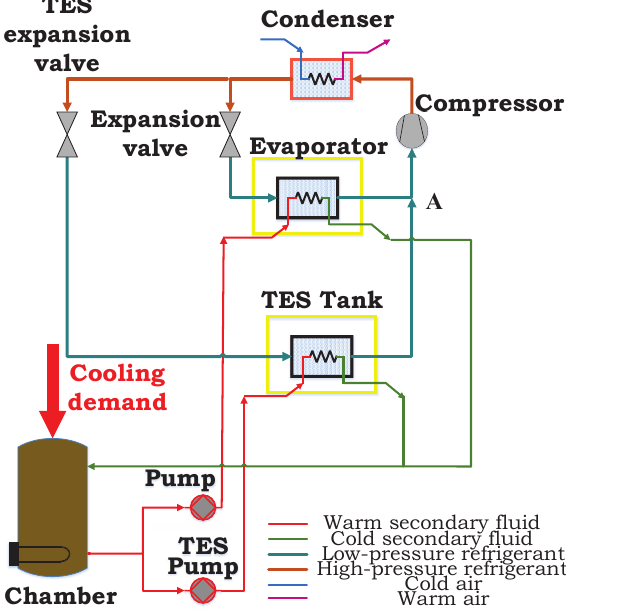
Figure 1. Layout of the refrigeration system with cold-energy storage. (TES denotes thermal energy